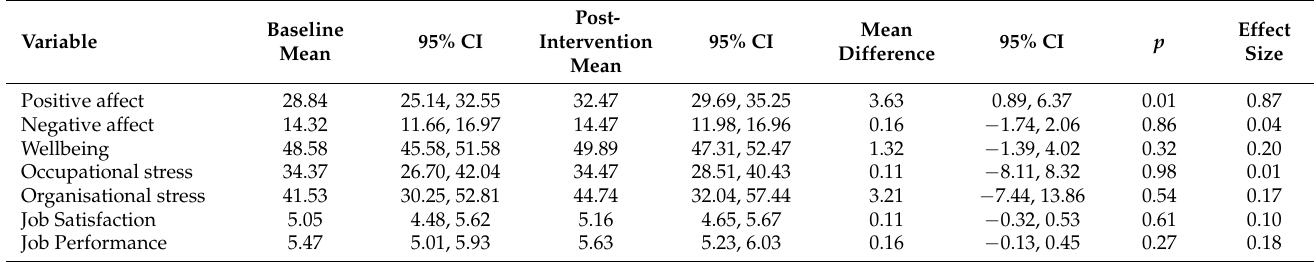
Table 5. Changes in affect, wellbeing, occupational and organisational stress, job satisfaction and job performance from baseline to post-intervention ( n =